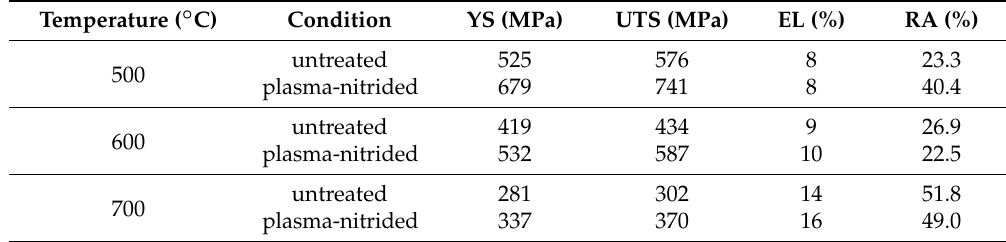
Table 2. Tensile data obtained from tensile tests on untreated and plasma-nitrided Ti-6Al-4V alloy. Temperature ( ◦